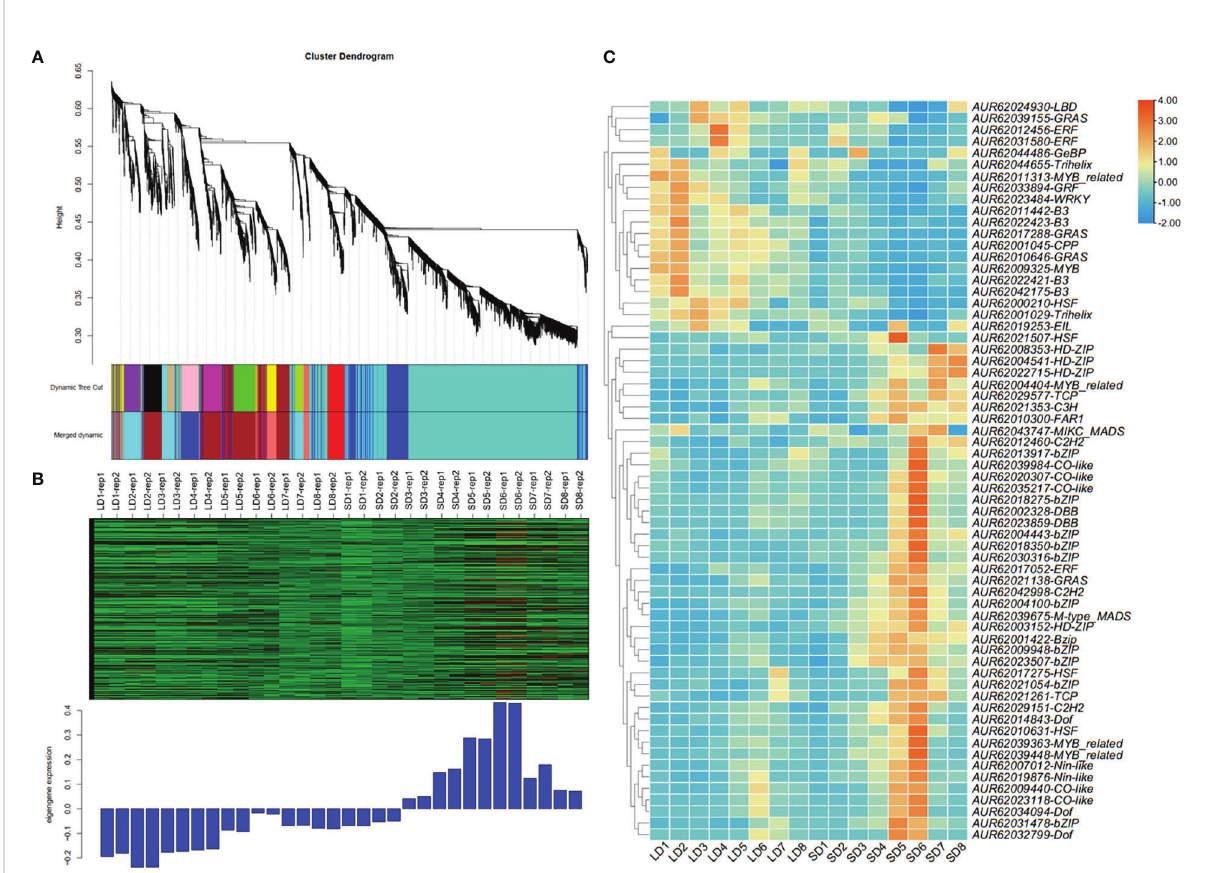
FIGURE 12 Weighted gene co-expression network analysis and transcription factor prediction methods were used to identify the co-expressed TFs with CqFTL5 and CqFTL8 . (A) All the expressed genes were sorted into 6 co-expressed modules by applying weighted gene co-expression network analysis. (B) CqFTL5 and CqFTL8 were clustered into blue module containing 934 co-expressed genes. SD1 to SD8, or LD1 to LD8, refers to the samples diurnally collected at 17:00, 20:00, 23:00, 02:00, 05:00, 08:00, 11:00 and 14:00. (C) Heatmap shows the expression levels of 64 TFs identi fi ed from blue